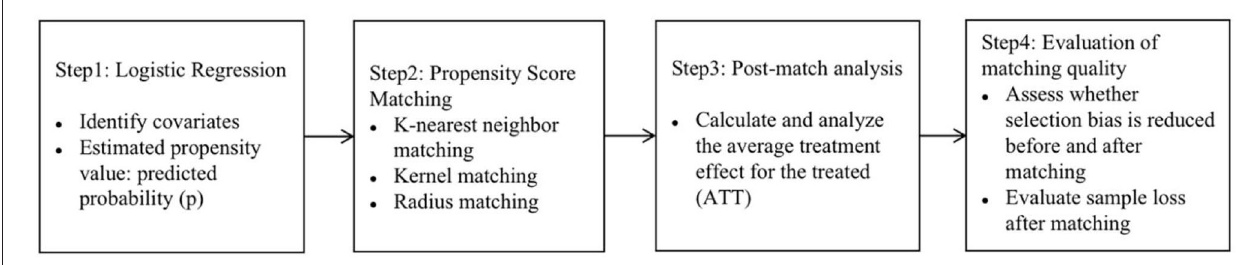
FIGURE 1 | The steps of